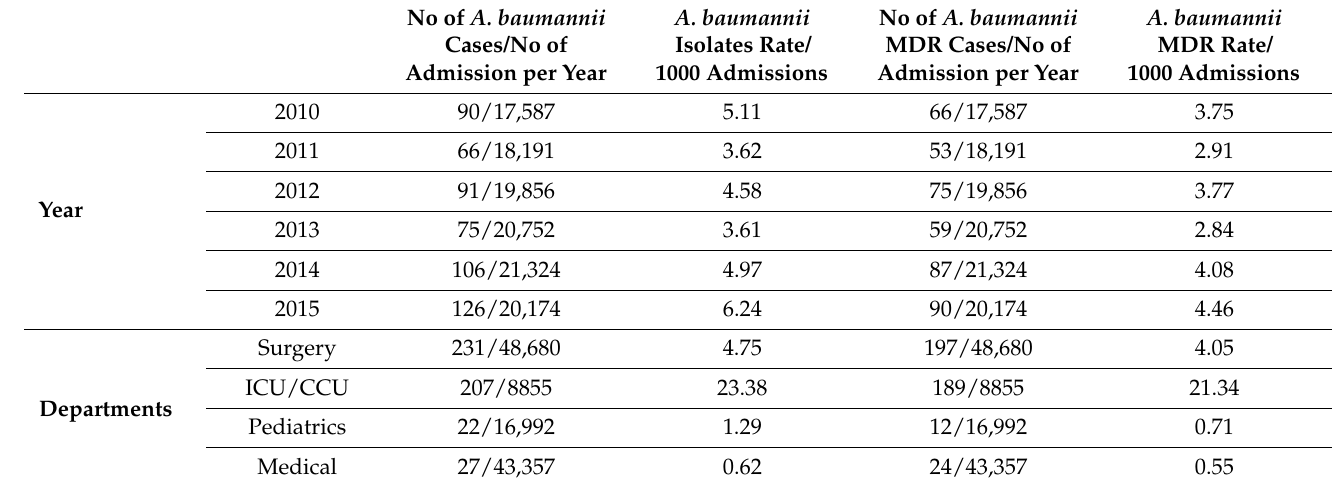
Table 3. Incidence rate of A. baumannii and A. baumannii MDR infections by year and hospital department.